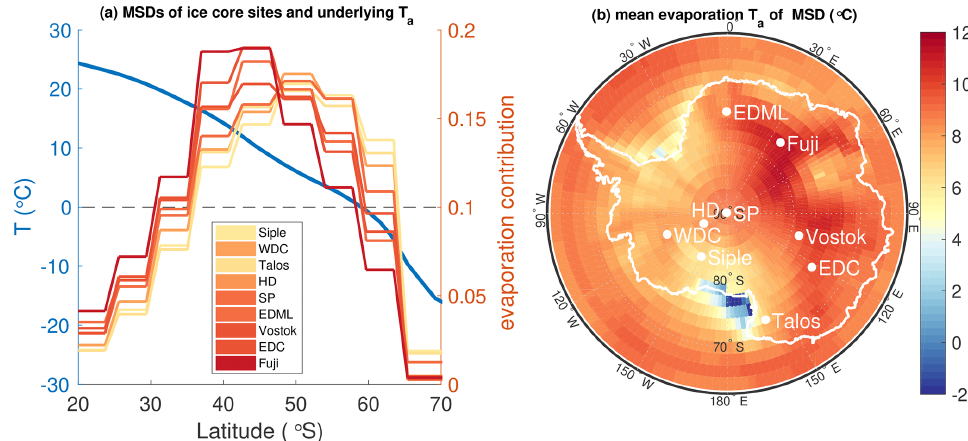
Figure A28. Annual mean temperature of moisture source regions from moisture-tagged GCM experiments. (a) Annual mean zonal-mean surface air temperature vs. latitude (blue) overlain with annual mean MSDs for several ice-core sites, colored by MSD-weighted annual mean air temperature. (b) MSD-weighted annual mean air temperature for every model grid point over the Antarctic. Note that this is not strictly the evaporation-weighted air temperature; it is weighted by location but not necessarily by time and may thus be biased to be too low.